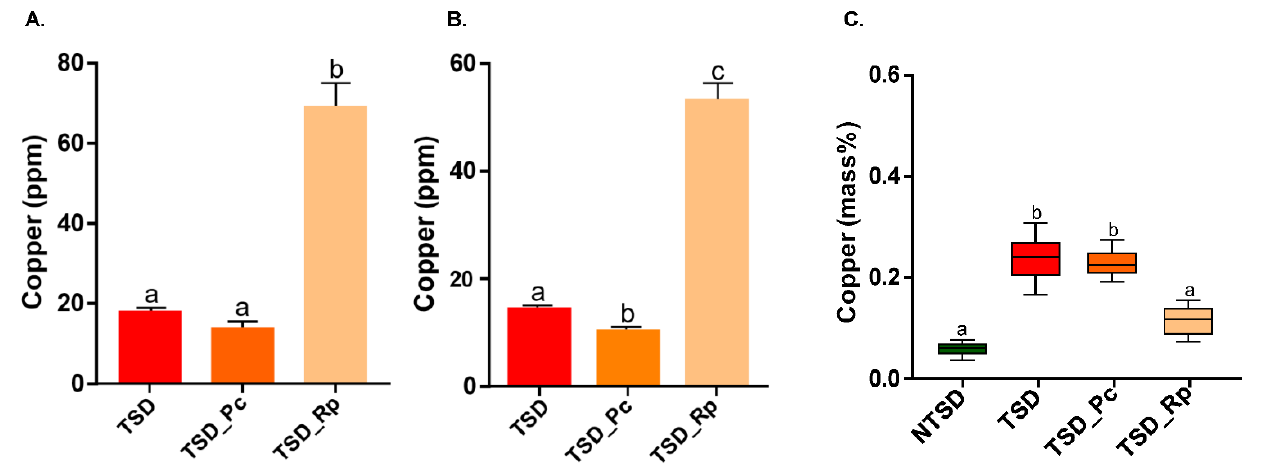
Figure 2. Copper quantification in liquid and solid phases of the microcosm after 10 days of P. chrysosporium and R. placenta growth with TSD (TSD_Pc/TSD_Rp). Amount of copper retrieved in the liquid phase measured by XRF ( A ) and ICP-OES ( B ). TSD represents the control without fungus. XRF = mean ± s.e., n = 3; ICP-OES = mean ± s.e., n = 6. ( C ) Copper quantified in wood by SEM-EDS microanalyses. The amount of copper was expressed as the estimated mass fraction of copper in the sample (mean ± s.e., n = 9; one-way ANOVA and Tukey’s post hoc test ( p -value ≤ 0.05), different letters to show statistically significant differences).